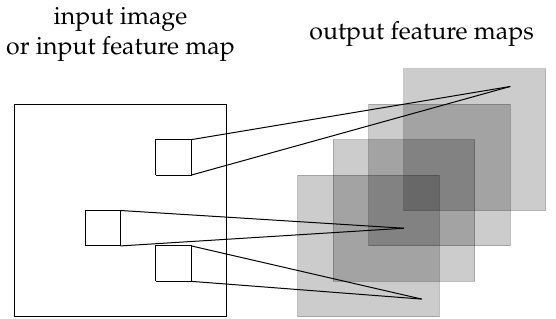
Figure 8. Illustration of a convolutional layer.